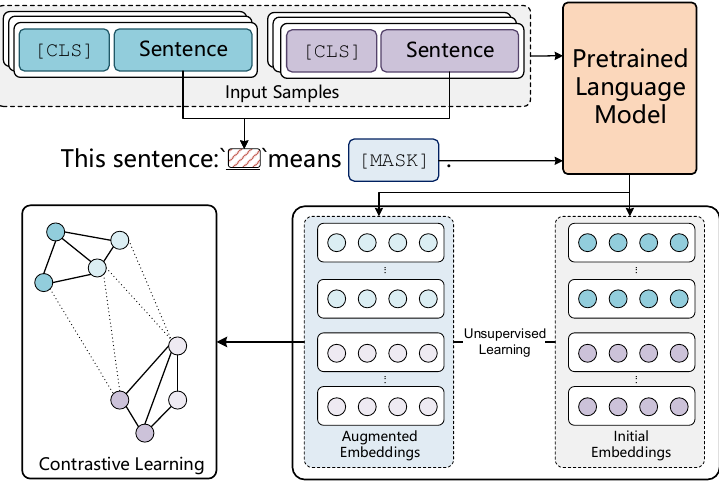
Figure 1. The cloze-style data augmentation model. In contrastive learning, the dashed lines mean moving points away from each other, and solid lines mean moving points closer to each